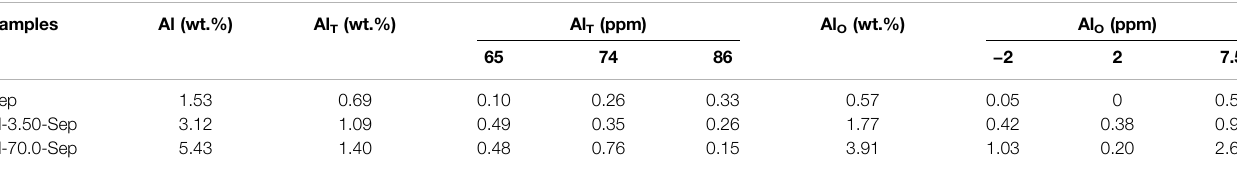
TABLE 5 | The calculated results of 27 Al NMR spectra of Sep, Al-3.50-Sep, and Al-70.0-Sep. Samples Al (wt.%) Al T (wt.%) Al T (ppm) Al O (wt.%) Al O (ppm) 65 74 86 − 2 7.5 Sep